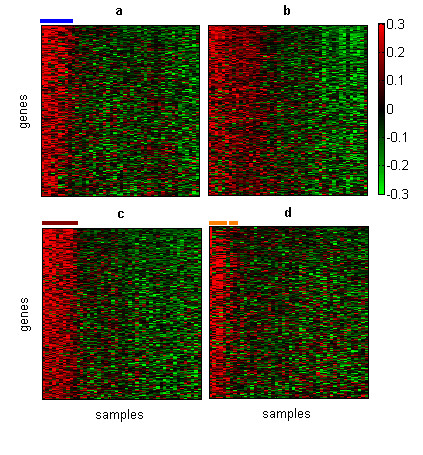
Structures from the soft-tissue tumor dataset Each heatmap represents the expression matrix in which samples and genes were sorted by (a) the first, (b) second, (c) third and (d) fourth basis gene and basis experiment. Only genes that were selected as highly representative of each basis experiment are shown. Blue line corresponds to monophasic synovial sarcomas, brown line to gastrointestinal stromal tumors and orange line to six of the eleven leiomyosarcomas samples.